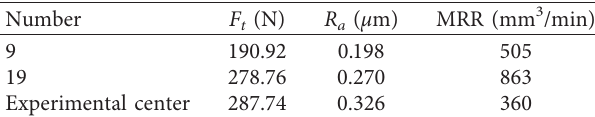
Table 8: Comprehensive optimized